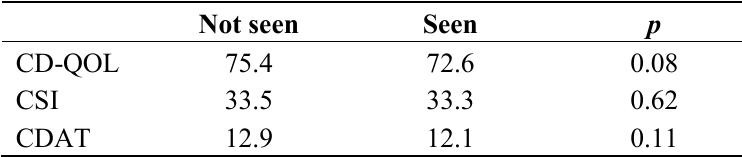
Table 3. Mean validated scores and use of a